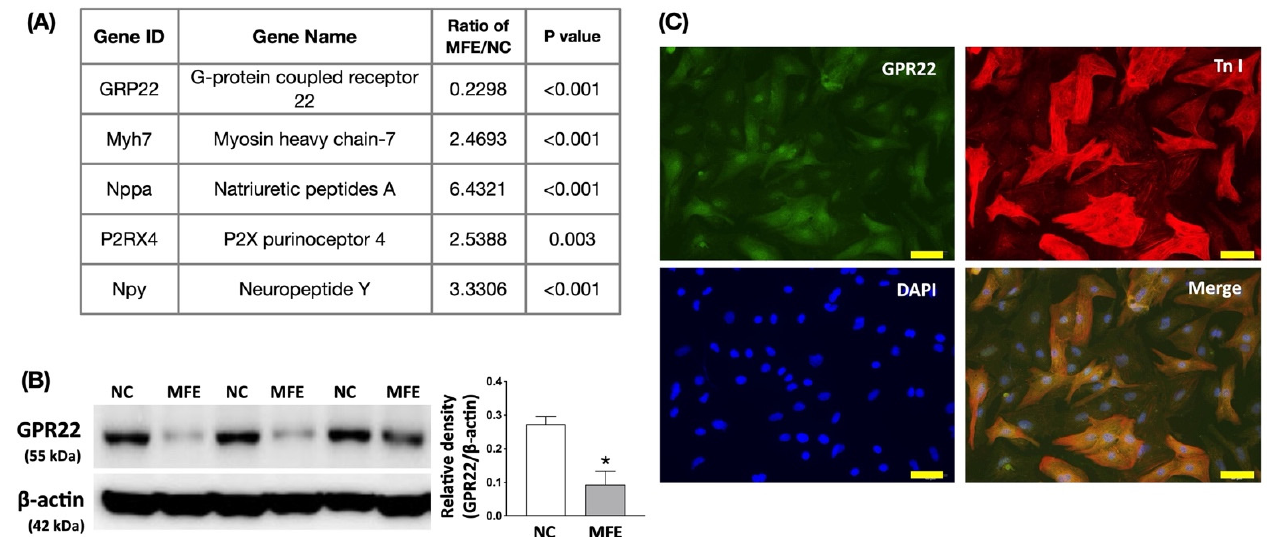
Figure 5. Maternal fructose exposure regulates gene expression levels of proteins involved in cardiac function and remolding. ( A ) The list of cardiac function-related genes with more than 2-fold changes in the myocardium of offspring with or without MFE. ( B ) Protein expression of GPR22 in the myocardium of offspring with or without MFE. ( C ) Immunofluorescent staining with antibodies against GPR22 and a cardiomyocyte marker, troponin I (Tn I), to examine the distribution of GPR22 in cardiac cells. NC, normal control. MFE, maternal fructose exposure. * indicates significance compared with NC group. Scale bar in right lower corner of ( C ) indicates 50 µm.